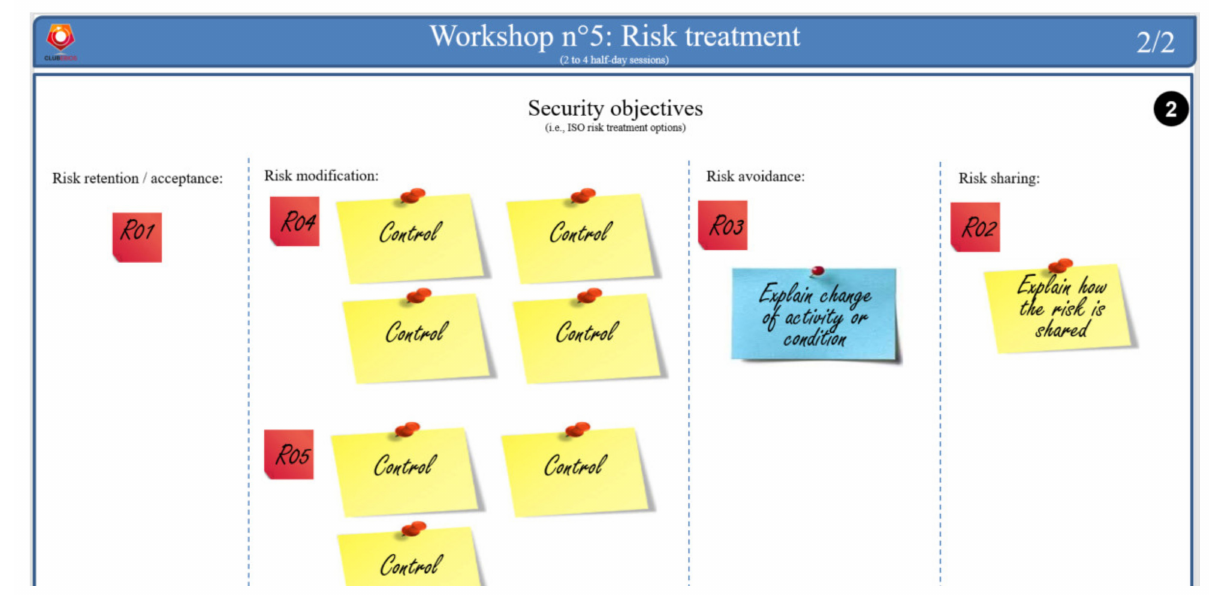
Figure 18. Ob é risk datasheet—workshop n ◦ 5: risk treatment action plan